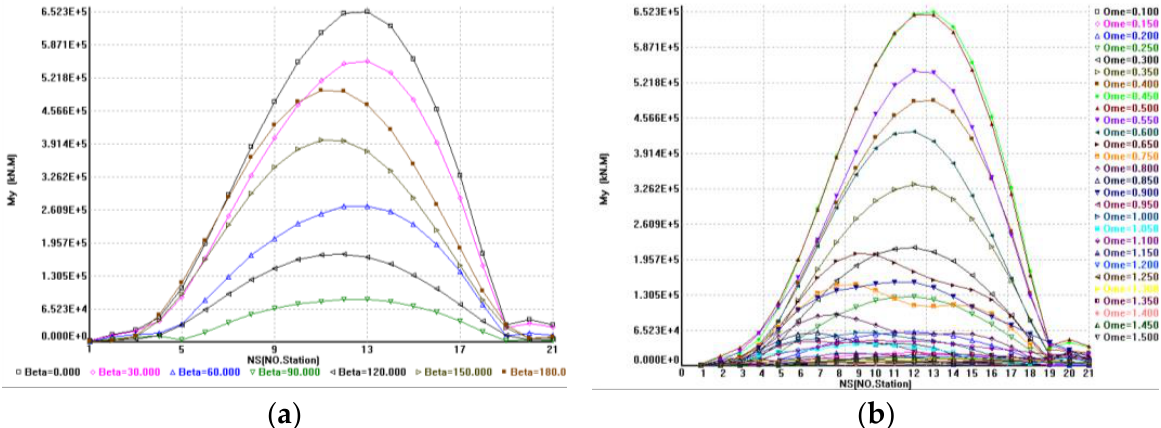
Figure 2. Variation of VBM with ship length ( v = 15 kn). ( a ) Under different wave angles; ( b ) under different wave frequencies. Table 2. Calculated work condition. Speed/kn Wave Angles/ ◦ Wave Frequency/rad/s Section (Distance from Aft Perpendicular)/m Wave